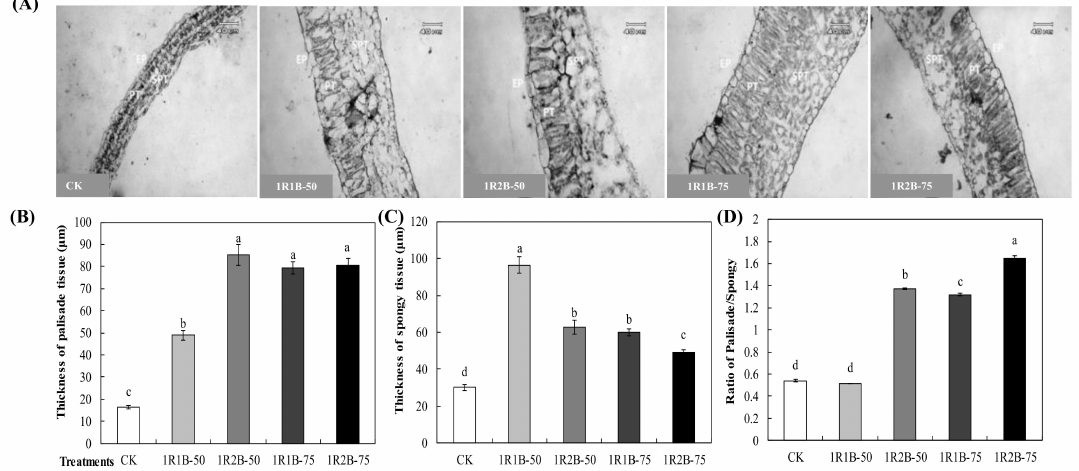
Figure 6. E ff ects of RB ratio and intensity of supplemental light on cucumber seedling leaf anatomical structure (PT: palisade tissue, SPT: spongy tissue. ( A )), palisade thickness ( B ), spongy thickness ( C ) and ratio of palisade / Spongy ( D ). Di ff erent letters indicate statistically significant di ff erences among treatments (ANOVA, p ≤